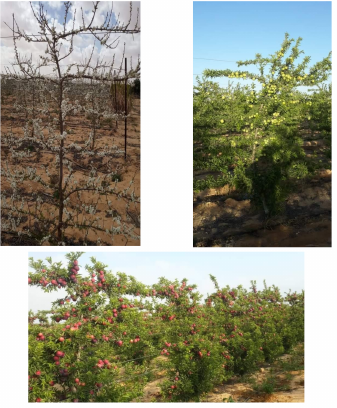
Figure 1. Flowering and fruit development of 5-year-old ‘African Rose’ plum in a wire training system on a 6-wire hedge under the semi-arid conditions of El-Khatatba, Menoufia, Egypt.